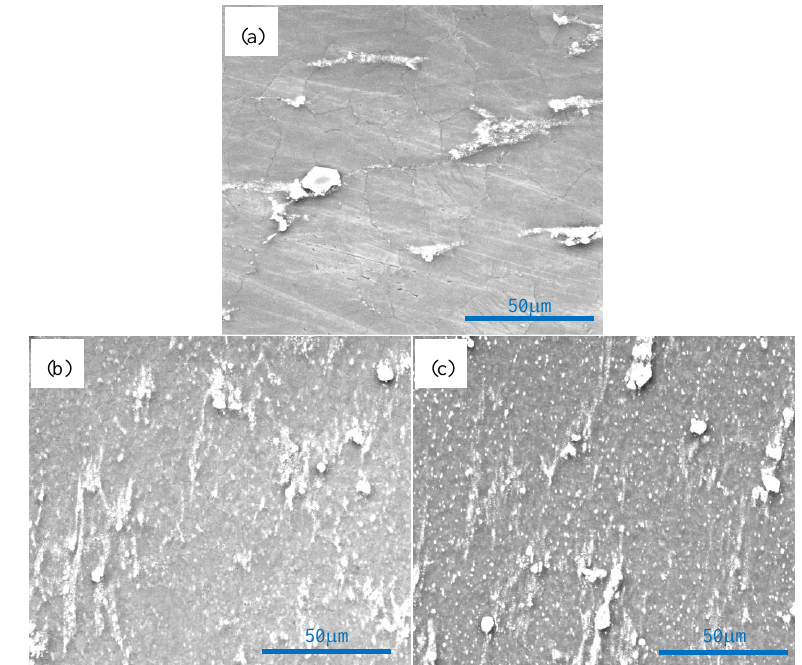
Figure 7. SEM images of nano-SiCp/AZ91 composite after multi-pass forging with varying temperatures: ( a ) 6 passes at 400 °C; ( b ) 6 passes at 400 °C and 3 passes at 350 °C; ( c ) 6 passes at 400 °C; 3 passes at 350 °C and 3 passes at 300 °C.